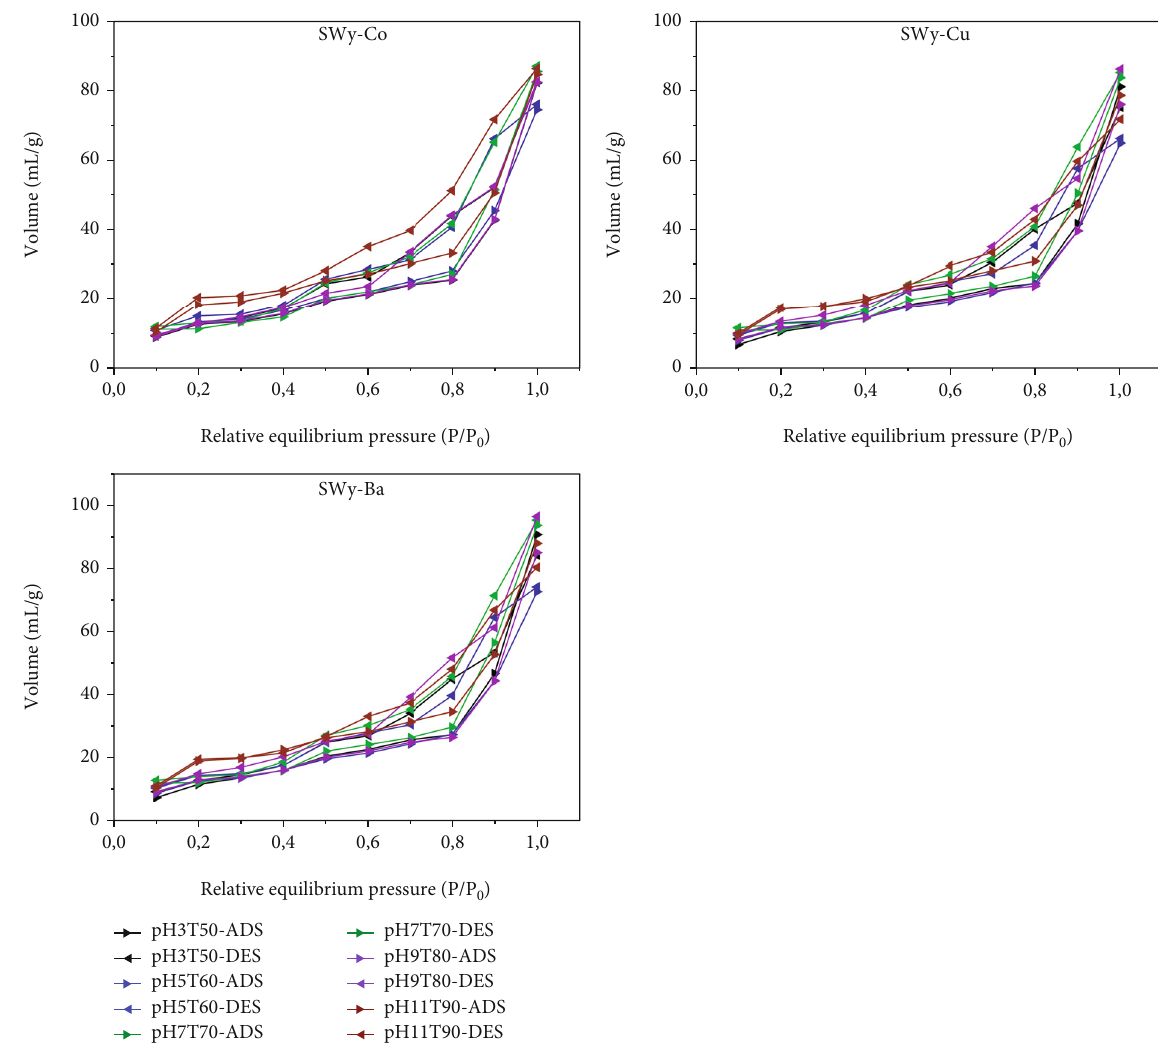
Figure 14: Nitrogen adsorption (ads)-desorption (des)-isotherms in the case of SWy-Co, SWy-Cu, and